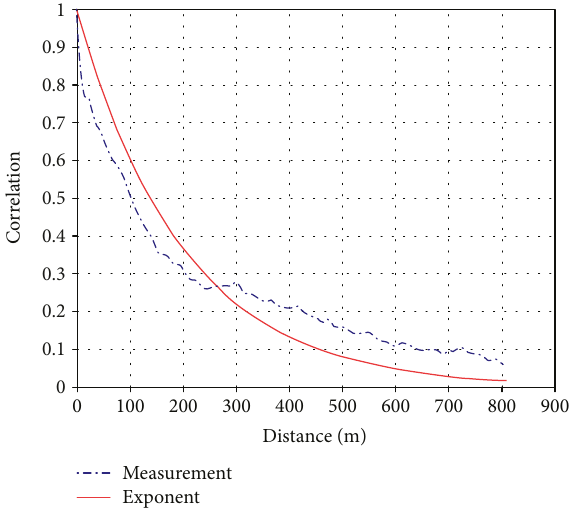
Figure 6: Slow fading correlation using scale 2 wavelet. The fading correlation distance is 152.5 meters for the wavelet method level